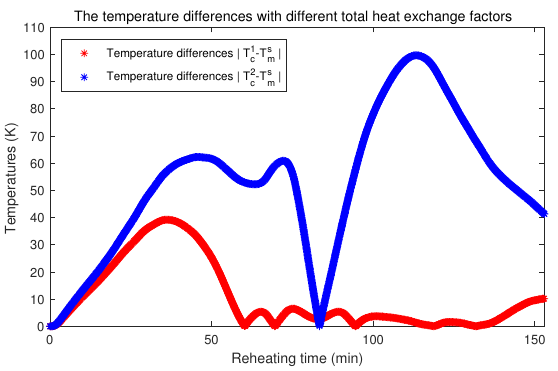
Figure 16. The temperature differences | T 1,2 c − T s m | with different total heat exchange